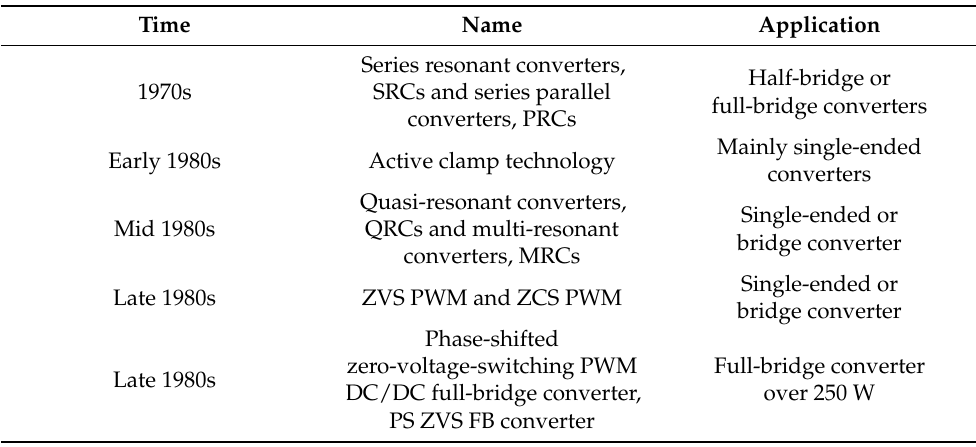
Table 1. Development history of soft-switching